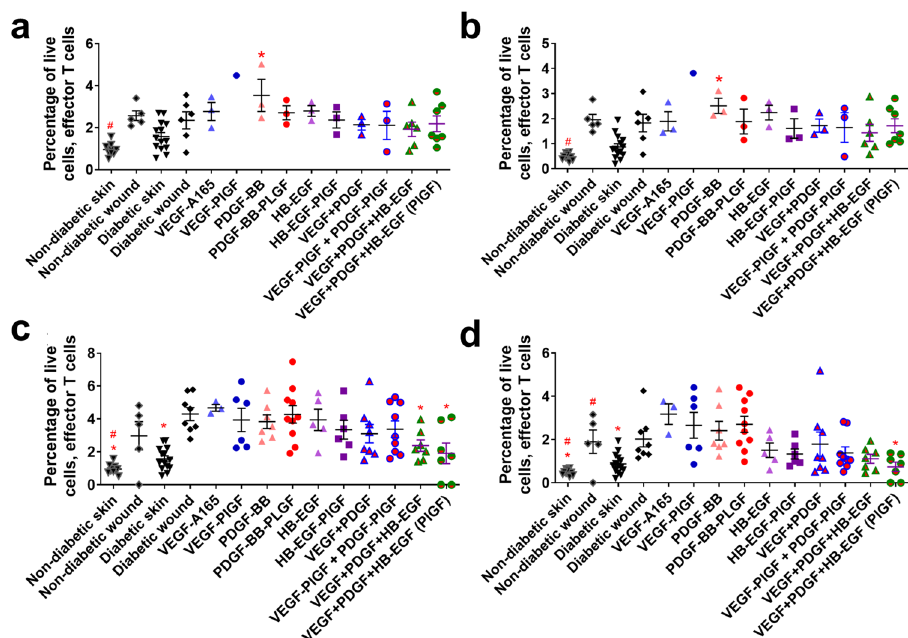
Fig. 7 Effector T cell count in wounds after 3 – 7 days of healing. Effector T cells (CD45 + , CD3 + , CD44 + , CD62L − ) at ( a ) 3 days or ( c ) 7 days. Subset of effector T cells that are amphiregulin positive at ( b ) 3 days or ( d ) 7 days. Comparison includes unwounded skin from both the NOD and NOR mice. n ranges from 3 to 20. * Denotes comparison to the diabetic wound. # Denotes a comparison between untreated NOD wound and untreated NOR wound, and the WT GF(s) are compared to their counterpart -PLGF-2 123 – 144 variant(s), e.g., VEGF vs VEGF-PlGF-2 123 – 144 . * p < 0.05, p < 0.01, p < 0.001, ANOVA + Student t -test for post hoc. # p < 0.05, p < 0.01, p < 0.001, Student ’ s t -test. Error bars are